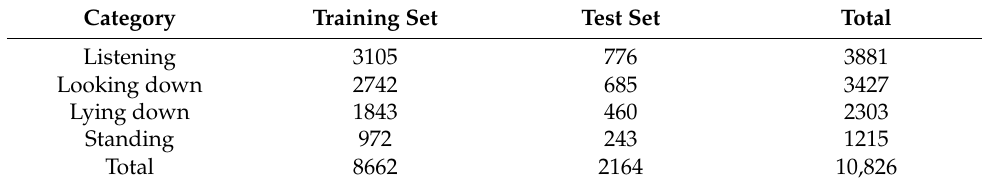
Table 1. The number of labels in the student behavior dataset.